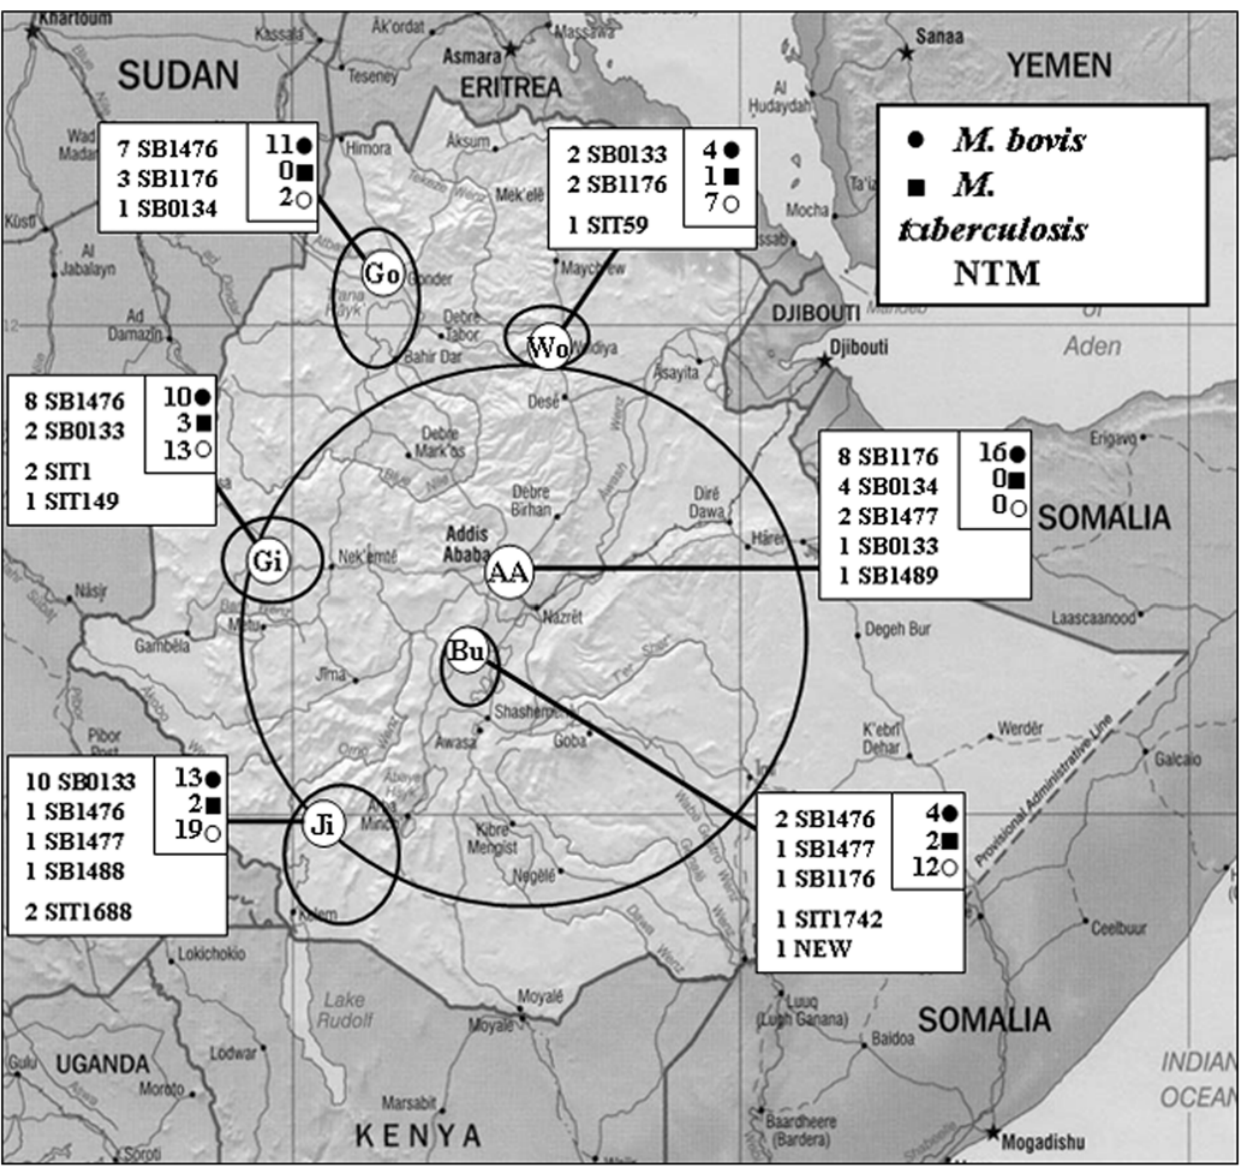
N ), M. tuberculosis ( & ),